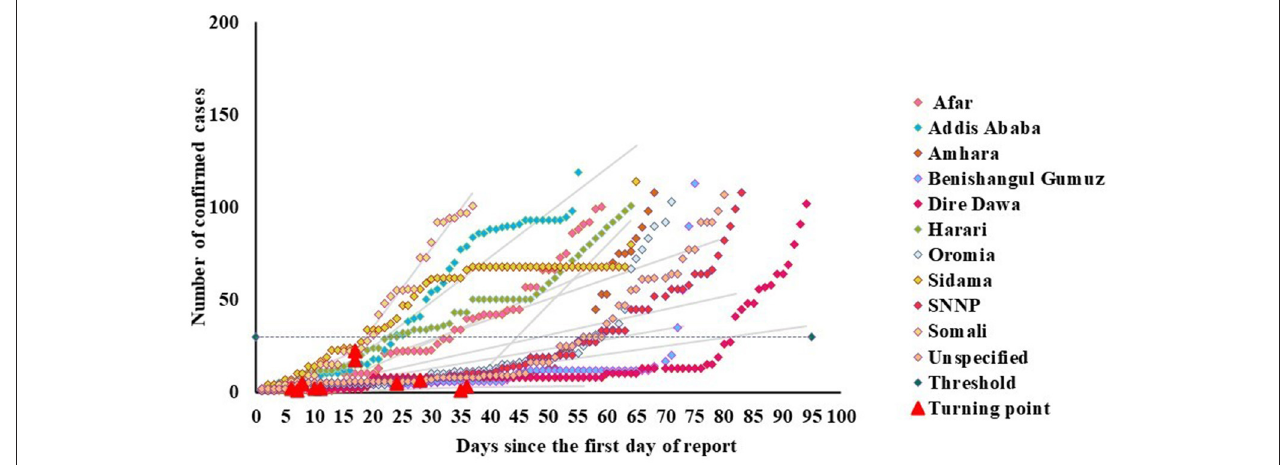
FIGURE 1 | Joinpoint two-phase fitting for Ethiopia regional states, showing the transition point below a threshold of 30 cases.